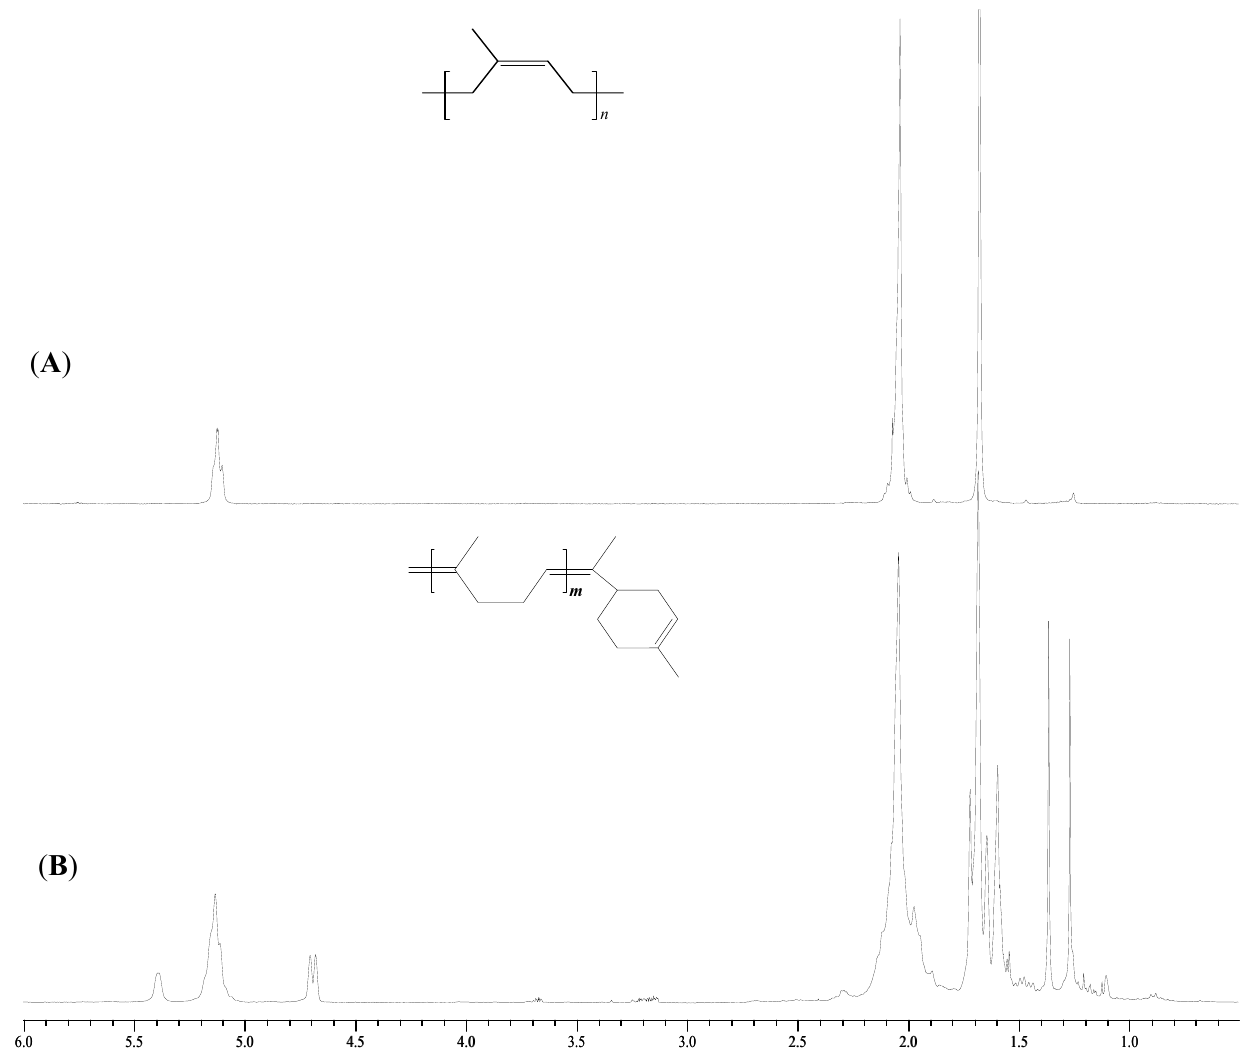
) spectra of NR before ( A ) and after ( B ) the 3